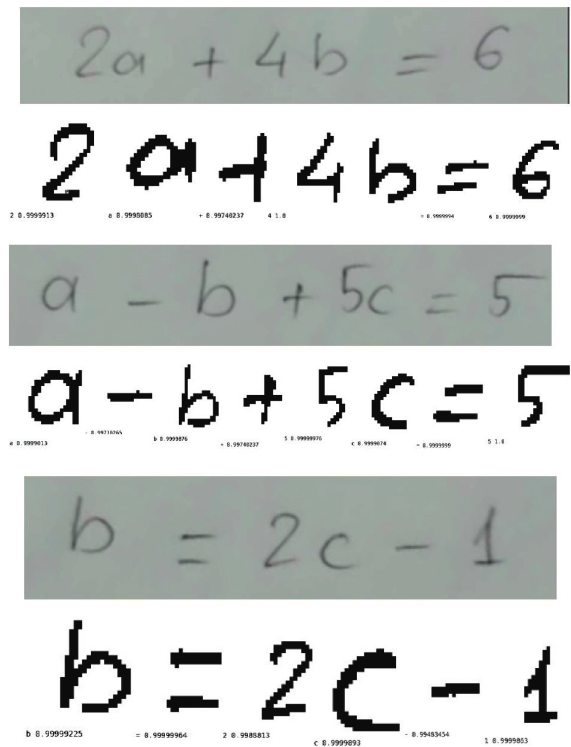
Figure 17: Result of character